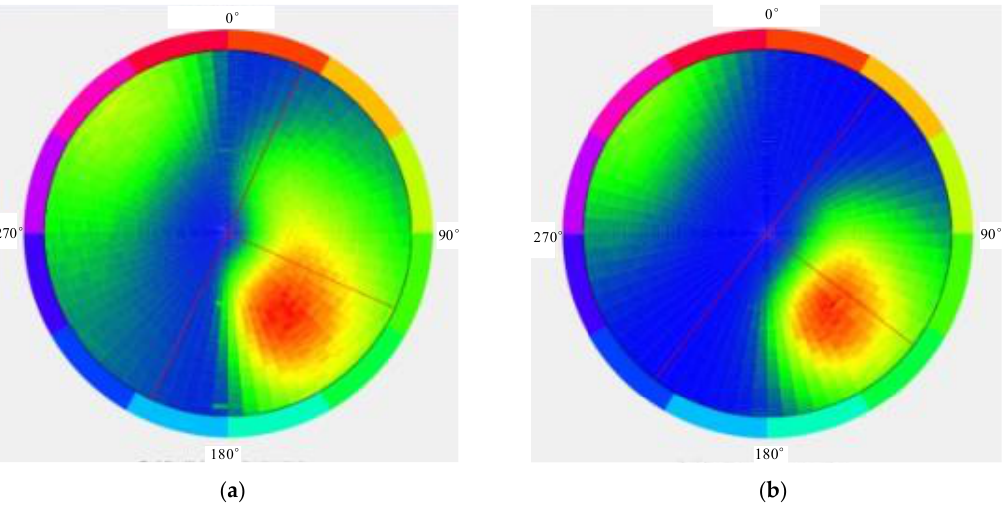
Figure 14. Occurrence distribution of micro-elements on a large-scale bank slope. ( a ) Occurrence distribution of micro-elements (30 August 2019). ( b ) Occurrence distribution of micro-elements (24